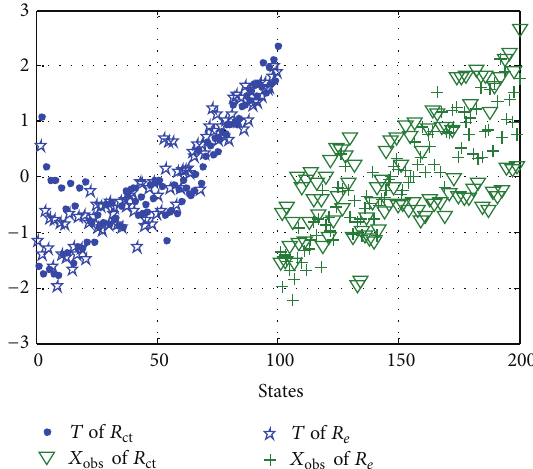
Figure 10: Training data 𝑇 and observation matrix 𝑋 𝑅 . ct